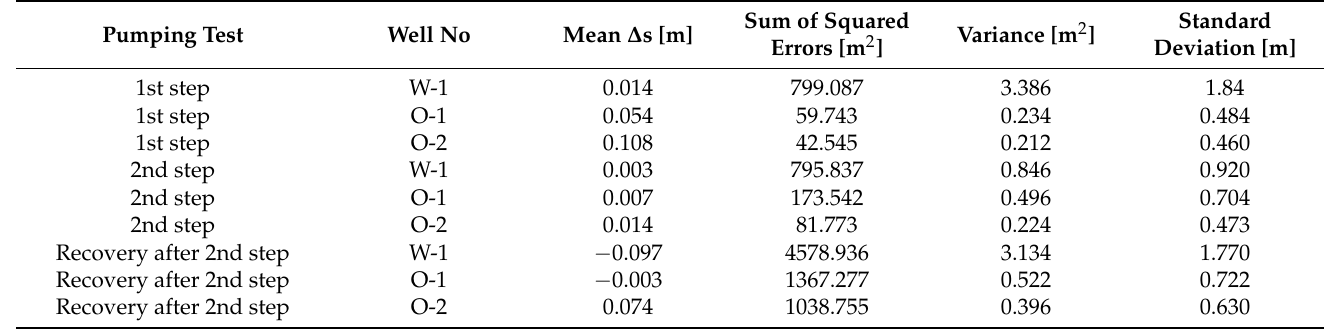
Table 1. Matching statistics between measurements taken during the pumping test and model values calculated with the